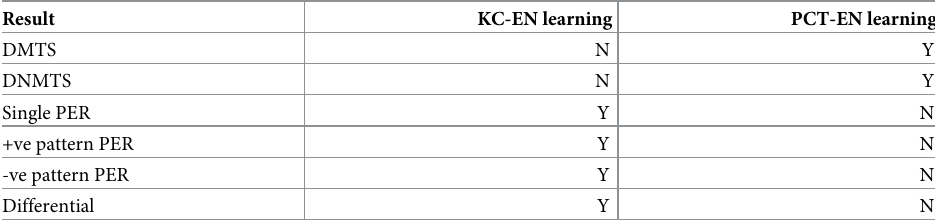
Table 1. Sufficiency table showing which learning mechanisms in the model are required for each result. Result KC-EN learning PCT-EN learning DMTS N Y DNMTS N Y Single PER Y N +ve pattern PER Y N -ve pattern PER Y N Differential Y